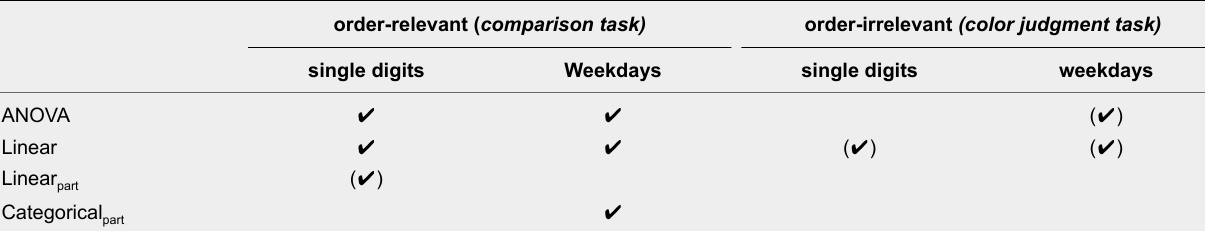
Emergence of SNARC and SNARC-like Effects in the Different Tasks and Stimulus Sets as a Function of Analysis Approach order-relevant ( comparison